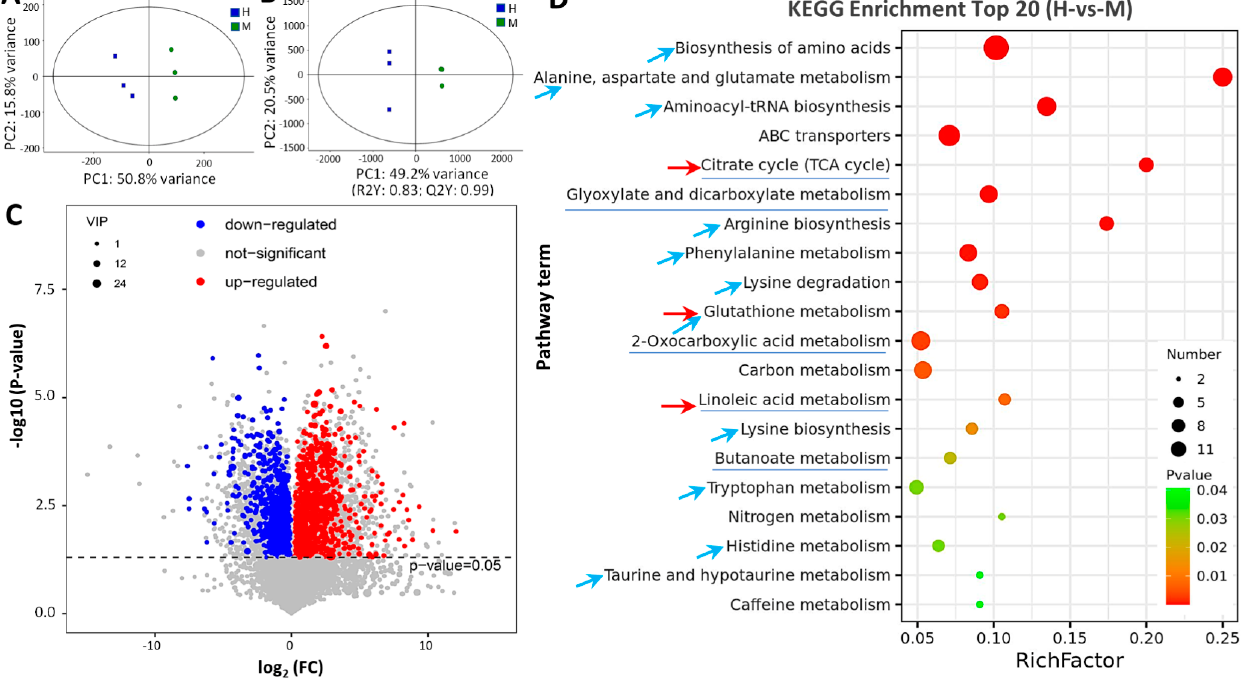
Figure 5. General overview of differentially accumulated metabolites (DAMs) in rice leaves under HSA stress. ( A ) PCA score scatter plots of metabolites determined via UHPLC − MS/MS. Different colors represent different groups. Blue, MSA group; red, HSA group. X-axis and Y-axis indicate the first and second principal components (PC1 and PC2), respectively. Score plots for PC1 and PC2 show cohesion within groups and separation between MSA and HAS groups. ( B ) OPLS − DA scatter diagram for HSA and MSA groups. R2X and R2Y represent the explanatory rate of the model to x and y matrices, respectively. ( C ) Volcano plots of the DAMs for HSA vs. MSA. VIP > 1, p value < 0.05. Red points, upregulated DAMs; blue points, downregulated DAMs; gray points, metabolites with no significance. ( D ) Top 20 of KEGG enrichment terms for HSA vs. MSA. The p value is pre- sented in a color scale, the size of the dots represents DEG number mapped in each pathway. The blue arrows indicate amino acid metabolic pathways, the blue lines indicate organic acid metabolic pathways.